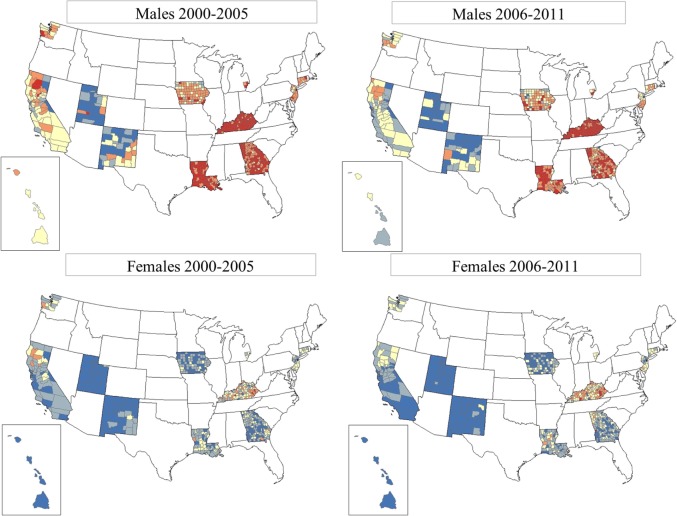
Total lung cancer incidence rates by county for SEER17, excluding Alaska. From top row left: total lung cancer for males, period 1 (2000–2005); top row right: total lung cancer for males, period 2 (2006–2011). Bottom row left: total lung cancer for females, period 1 (2000–2005); bottom row right: total lung cancer for females, period 2 (2006–2011). SEER17_counties rate

0.00–41.82,

41.83–53.53,

53.54–68.15,

68.16–91.96, and

91.97–199.10.